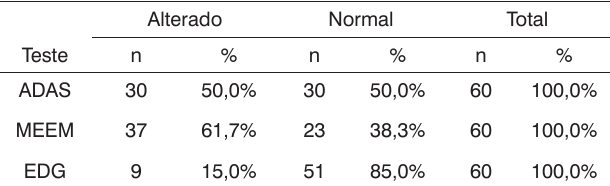
Tabela 1. Distribuições de frequências e porcentagens do ADAS-Cog, MEEM e EDG.